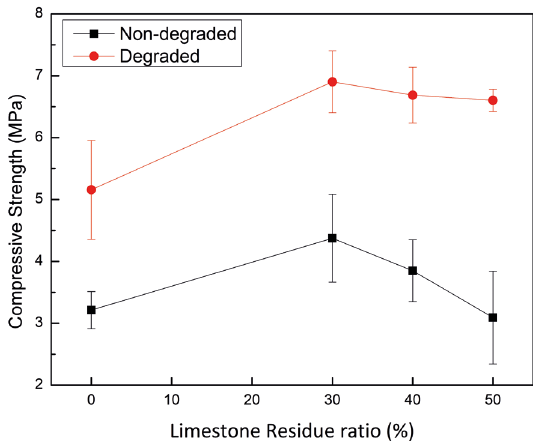
Figure 7. Compressive strength results after degradation The SEM analysis of the fracture surface of the soil-cement blocks with limestone residues both degraded and non-degraded revealed sensible differences. Figures 8 (a) to (d) present the fracture results for the samples of